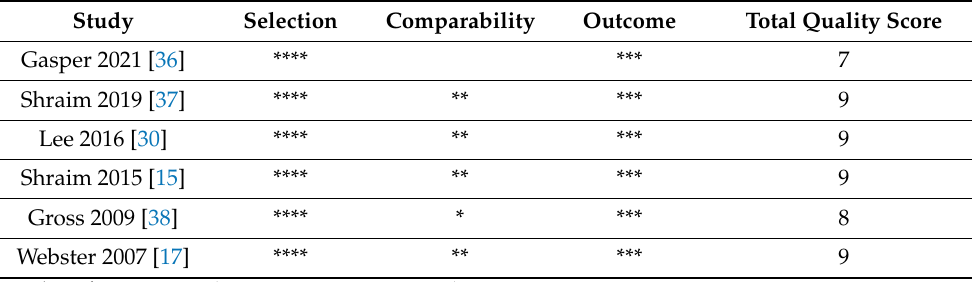
Table 2. Quality assessment of studies using the Newcastle–Ottawa scale. Study